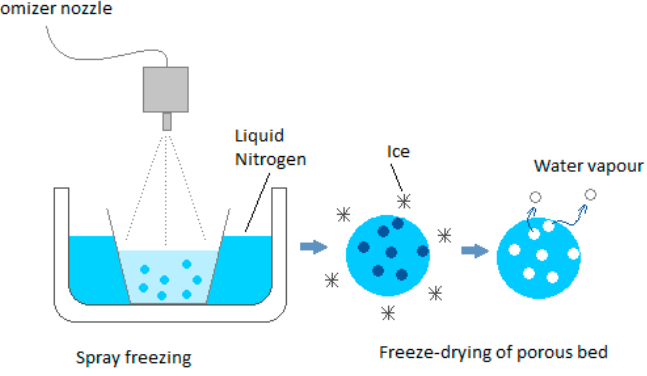
Figure 1. Producing a porous bed by freezing the suspension in a cryogenic fluid; adopted from